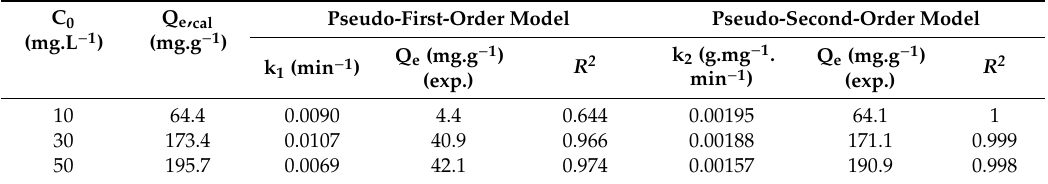
Figure 9. ( a ) Pseudo-second order plots and ( b ) the adsorption capacity ( q e ) for the adsorption of MB on SLS-C at various initial concentrations, pH = 5.0, S / L = 0.15 g · L − 1 , T = 25 ◦ C. Table 2. Pseudo-First-Order model and Pseudo-Second-Order model form removal of MB by SLS-C. C 0 (mg.L − 1